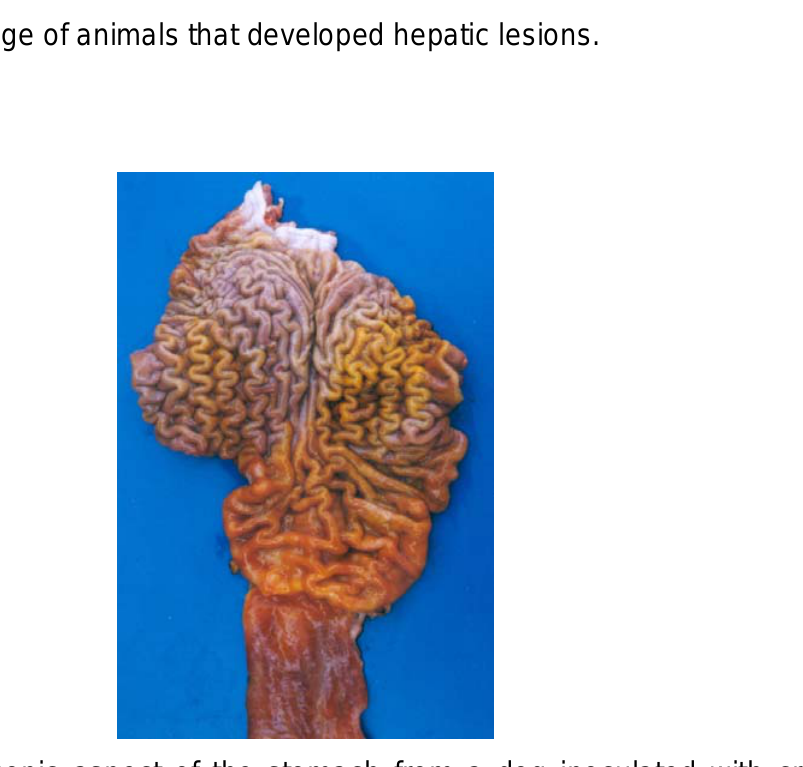
Figure 13. Macroscopic aspect of the stomach from a dog inoculated with crotalic venom, showing acute catarrhal